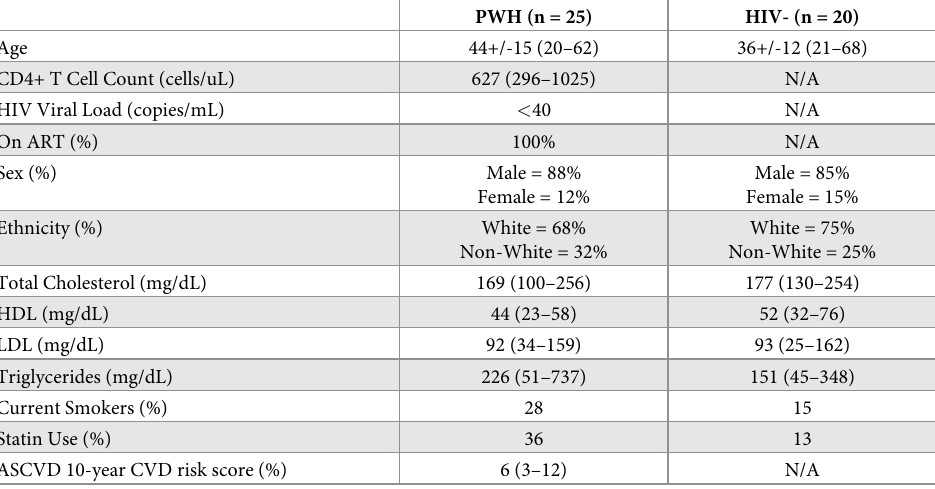
Table 1. Study Participant Demographics. Demographics and clinical characteristics of study participants with and without HIV. Data are displayed as means and ranges; age values also include standard deviation. (N/A, Not